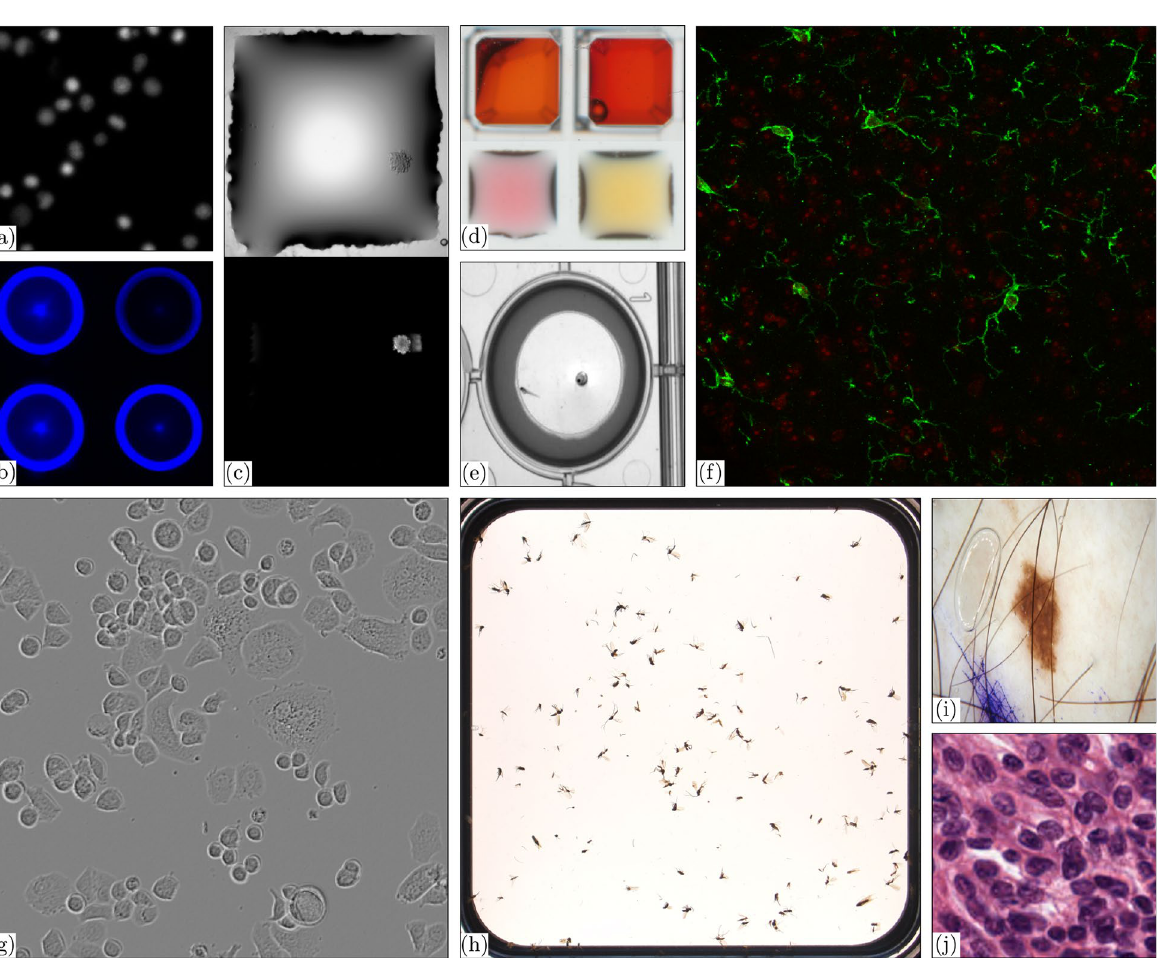
Figure 2. Heterogeneous Image Processing Data and Tasks of High-throughput Experiments. Exemplary tasks, such as ( a ) the detection of cell nuclei in fluorescence images, ( b ) the intensity analysis of spots in fluorescence 6 , ( c ) the detection of spheroids in bright-field or fluorescence images 7 , ( d ) the analysis of colorimetric scans, ( e ) drug screening via touch response analysis of zebrafish larvae 8 , ( f ) the detection of microglia, ( g ) the detection of cells in light microscopy 9 , ( h ) invertebrate biodiversity analysis 10 , ( i ) the inspection of skin lesions 11 , or ( j ) histopathology image analysis 12 , are shown to illustrate the heterogeneity and complexity of high-throughput experiments. To show the generalization of our concept, the presented data is not limited to the SPPO